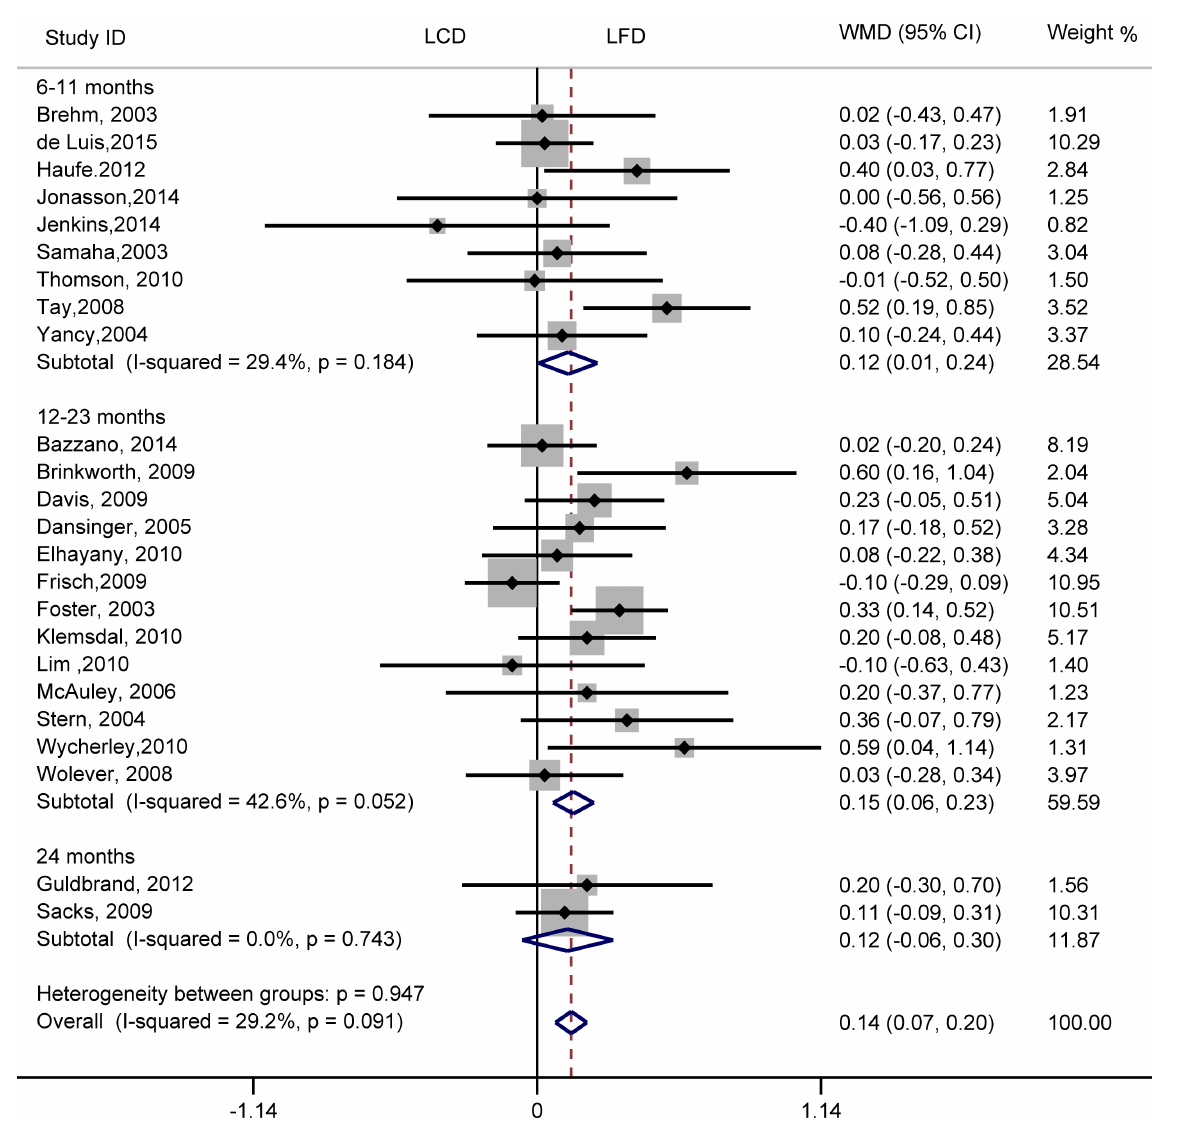
FIGURE4 Forest plots showing weight mean differences (WMD) and 95% CI for total cholesterol of the low-carbohydrate diets (LCD) in comparison with low-fat diets